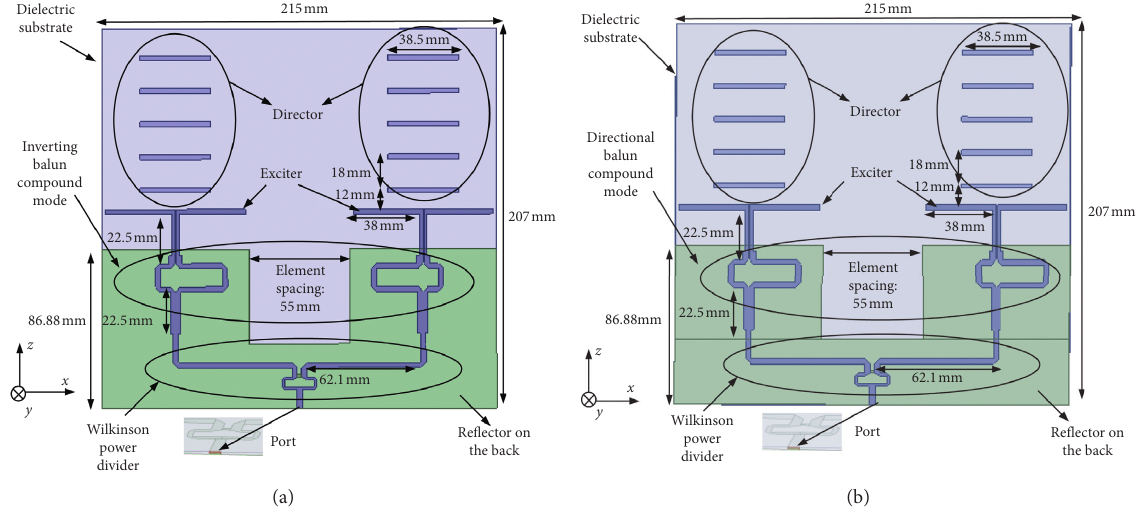
Figure 1: Reference antenna array structure. (a) Inverse balun. (b) Directional balun.